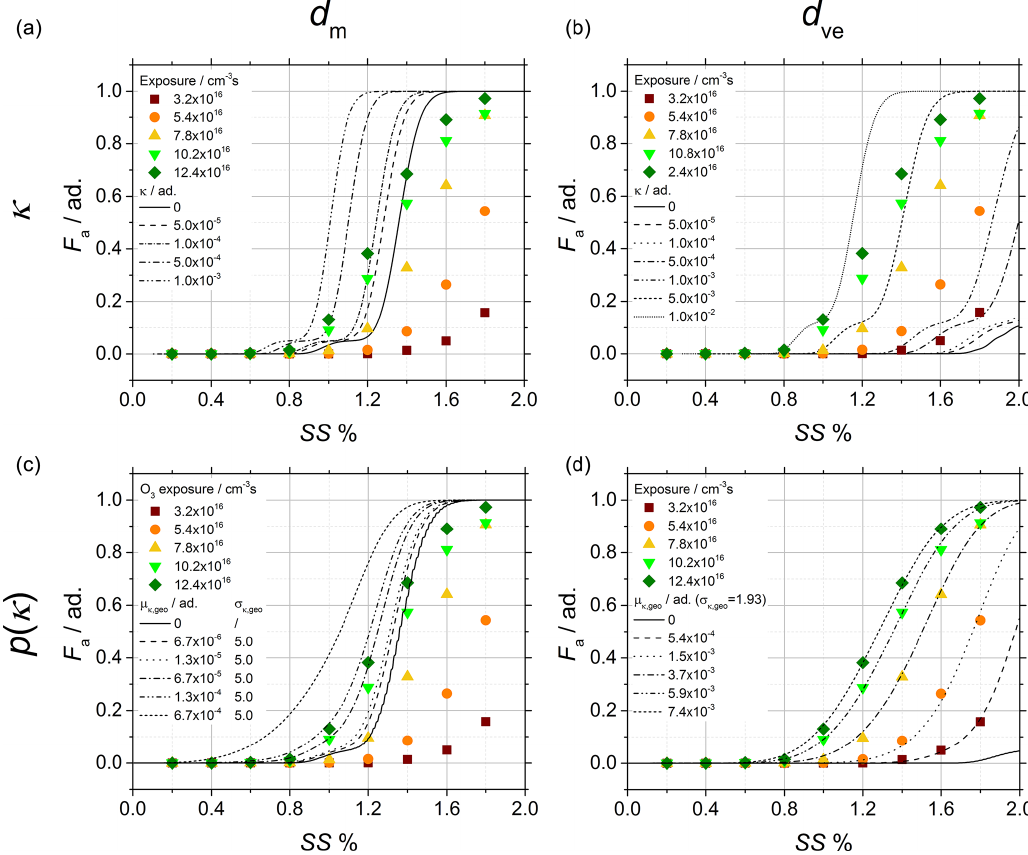
Figure 7. Soot sampled from the turbulent jet flame supplied with liquid kerosene at 70mm HAB. CCNc activation curves of the soot particles obtained after chemical aging with ozone and comparison of the experimental data (data points) to activation curves calculated under four different hypotheses (lines), each of them corresponding to the crossing of one row and one column as follows: (a, b) single κ value, (c, d) p(κ) , (a, c) mobility diameter after size selection and (b, d) morphology-corrected d ve .